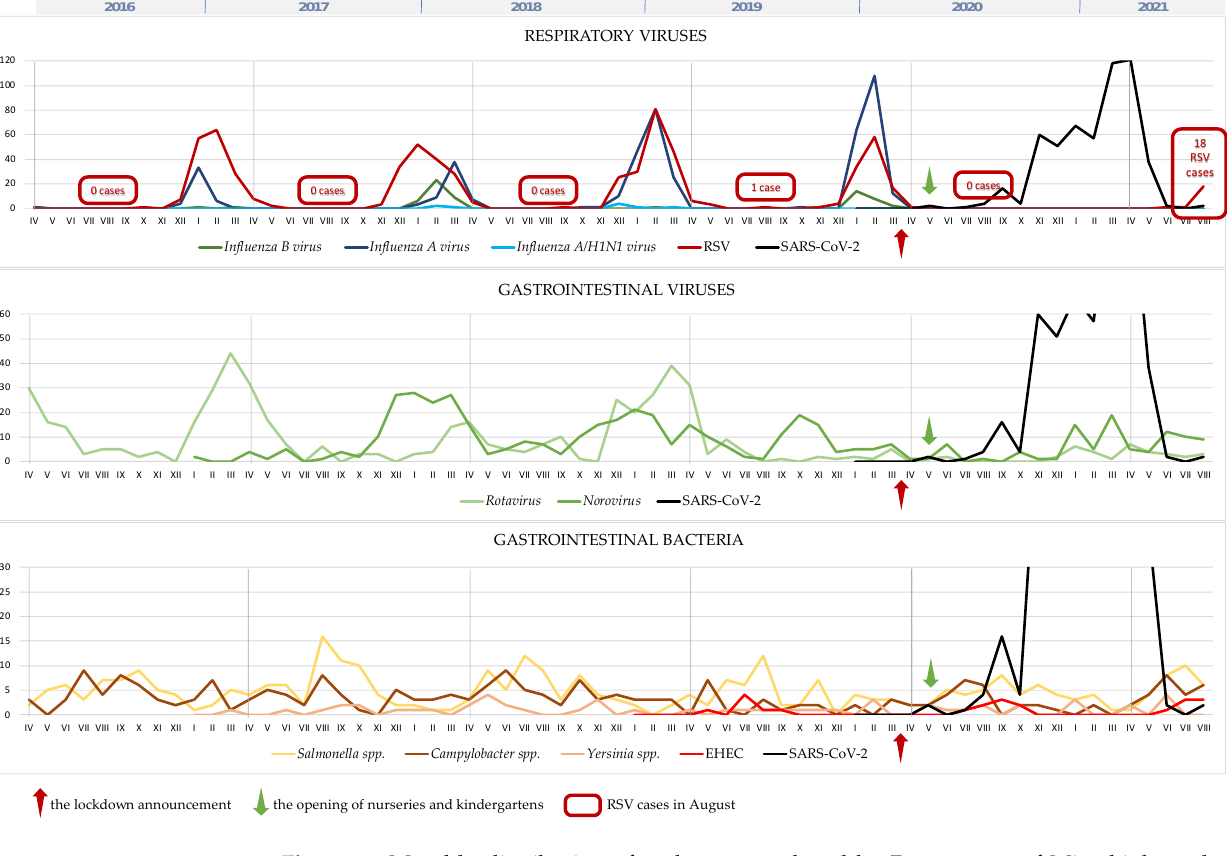
Figure 1. Monthly distribution of pathogens analyzed by Department of Microbiology during 2016 – 2021 seasons. RSV — respiratory syncytial virus, EHEC — Enterohemorrhagic Escherichia coli .